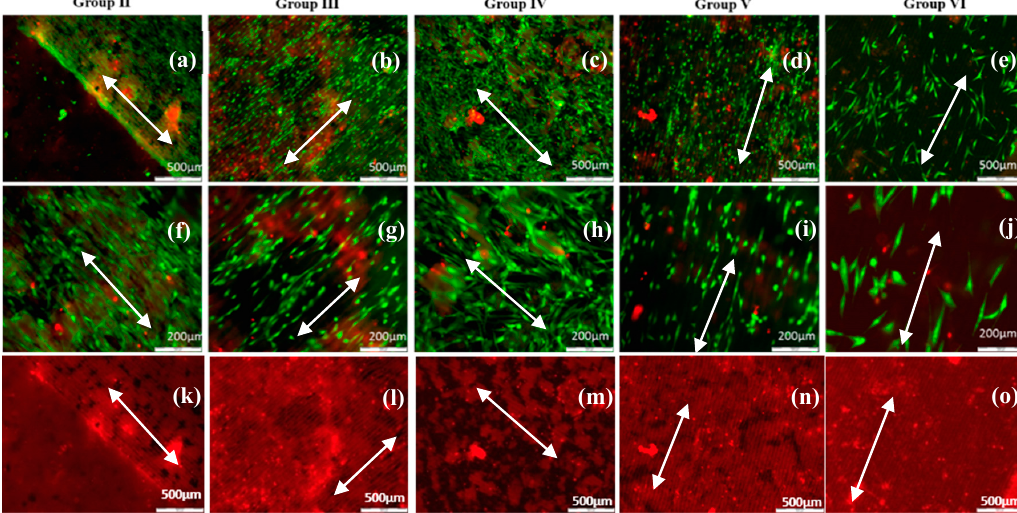
Figure 15. Fluorescence microscopy image of live-dead staining of ADSC stem cells distribution cultured for 6 days on Ch/HAp/ZrO 2 , fs laser modified in the form of stripes, thin composite films scale bar 200 µm ( a – e ). Close up images of ADSC stem cells orientation along structured surfaces, scale bar 500 µm ( f – j ), red fluorescent background images clearly show the lines/grooves on the samples ( k – o ); white arrows show the direction of surface patterning and the direction of the grooves, which coincided with that of the cells.